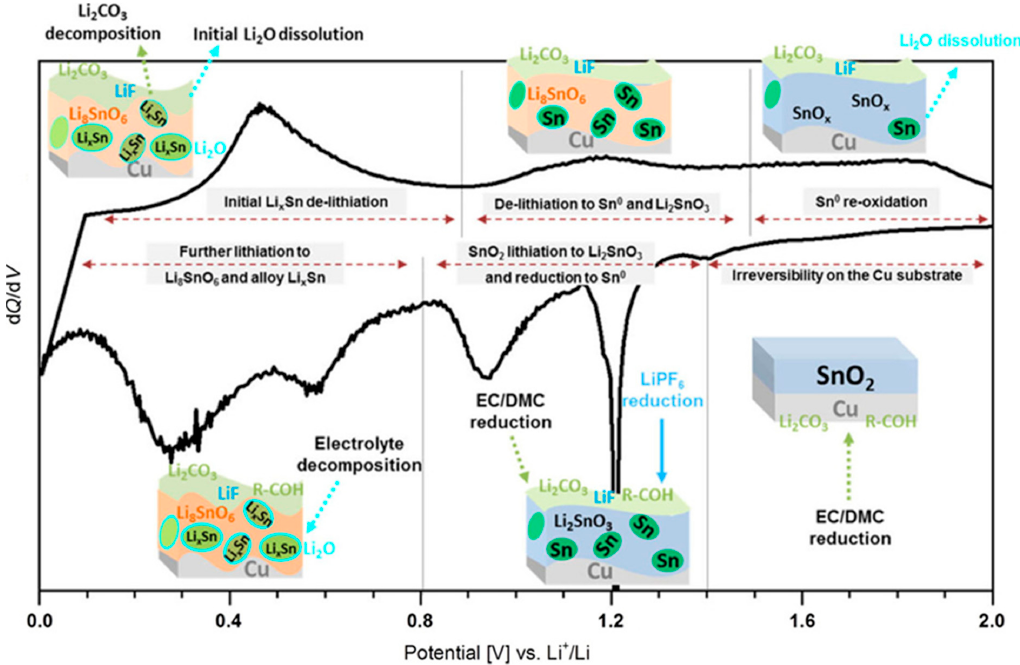
Figure 14. Cyclic voltammogram of a flat SnO 2 model electrode with a schematic representation of the electrode composition, intermediate phases during lithiation, and redox features associated with interfacial reactions with the organic and inorganic part of the electrolyte. EC = ethylene carbonate, DMC = dimethyl carbonate. Reproduced with permission from Ref. [156].